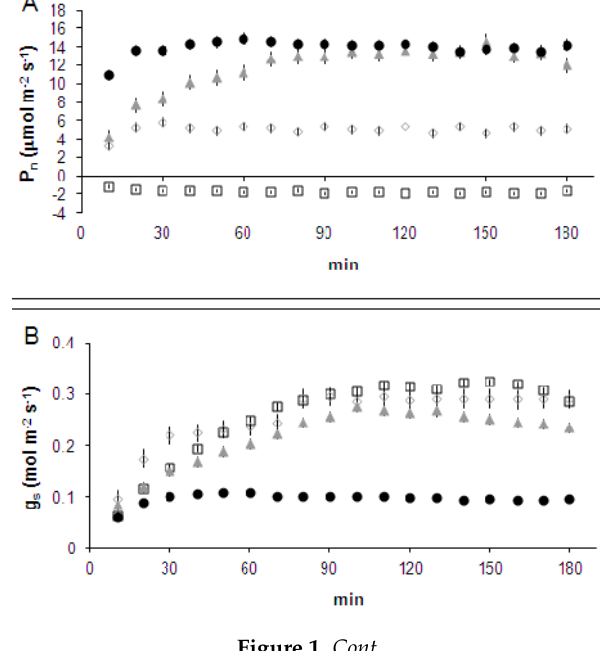
Figure 1. Cont. Figure 1.